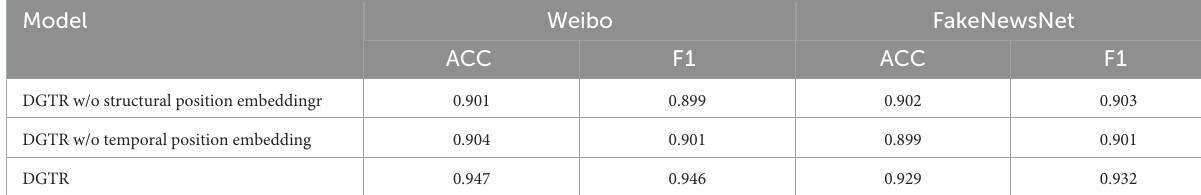
TABLE 4 Ablation study to verify the function of position